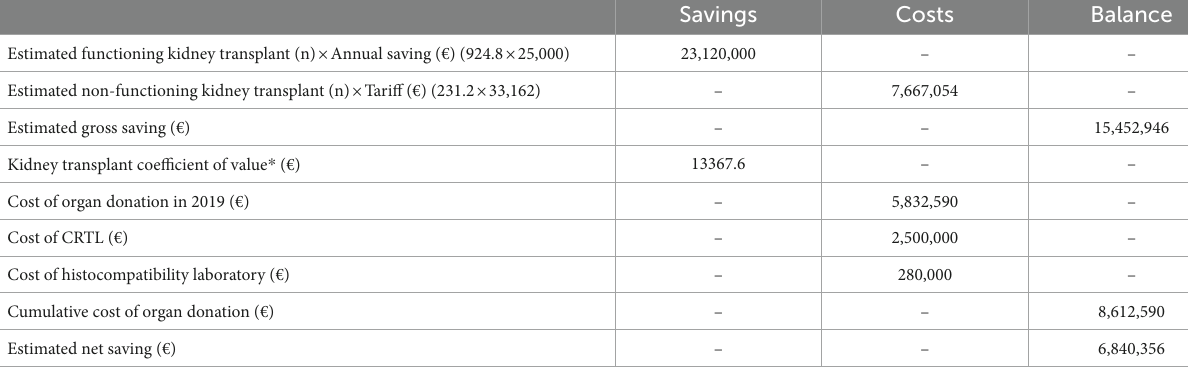
TABLE 2 Calculation of estimated gross savings and estimated net savings obtained in 2019.